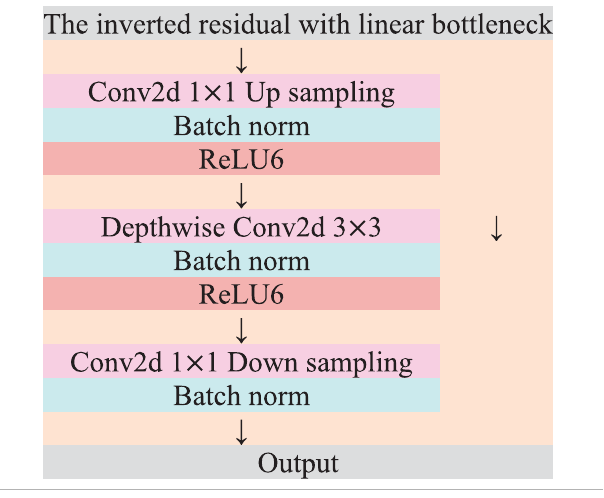
TABLE 1 | Inverted residual with linear